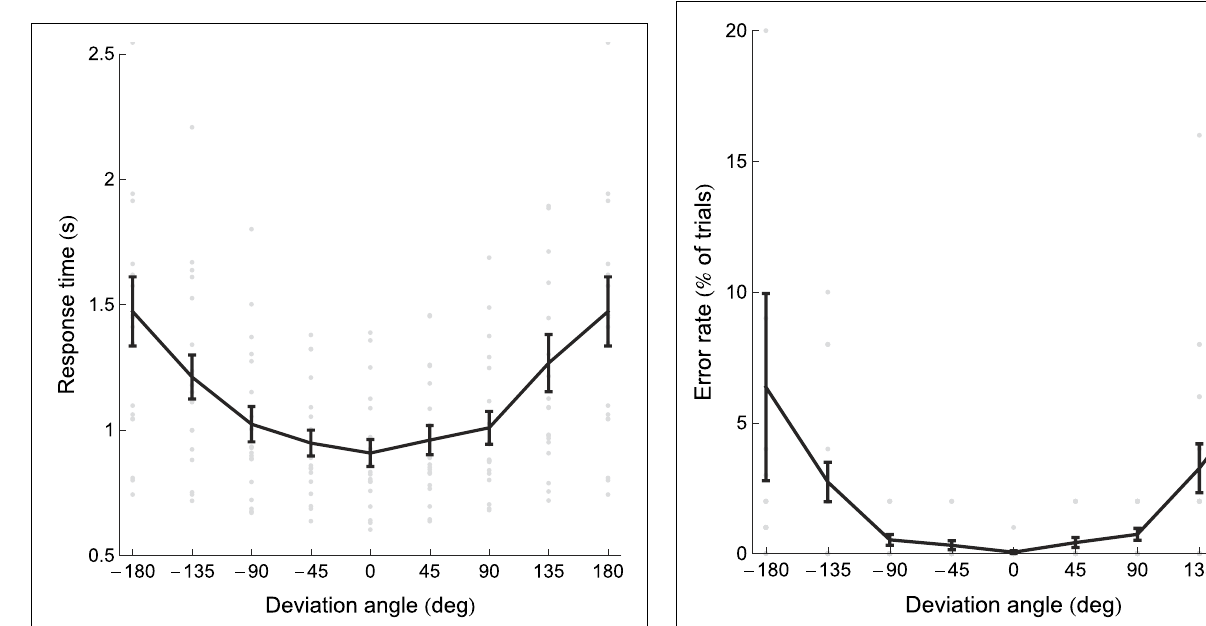
FIGURE 4 | Response times and error rates increase with absolute deviation angle. Gray dots represent individual participants’ data, the black curve the mean, and error bars between-subject SE.The data for deviation angles ± 180˚ is shown twice. Several outlying datapoints are not shown. Figure 4 shows the response times.